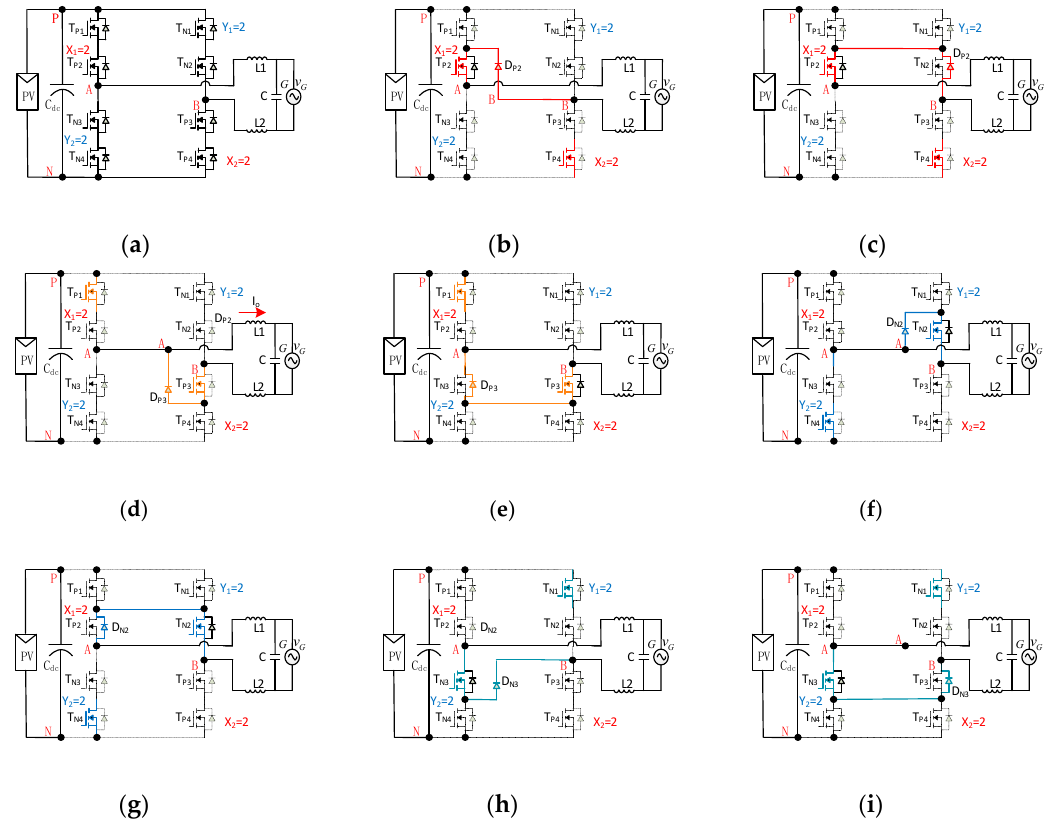
Figure 22. Six modes of M10 topology. ( a ) PC and NC modes; ( b ) PFT mode #1; ( c ) PFT mode #2; ( d ) PFB mode #1; ( e ) PFB mode #2; ( f ) NFT mode #1; ( g ) NFT mode #2; ( h ) NFB mode #1; ( i ) NFB mode